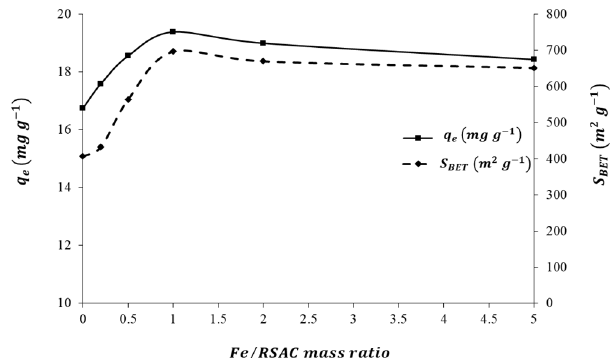
Figure 3. Effect of Fe loading quantity on nanocomposite adsorption capacity of Pb(II)